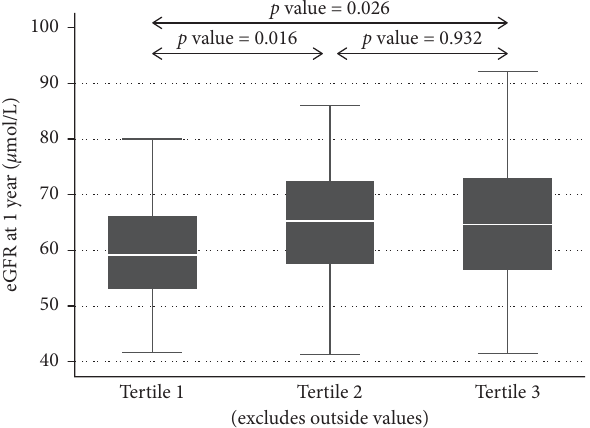
Figure 3: Donor eGFR and donor kidney volume by tertile at 1 year after donation.